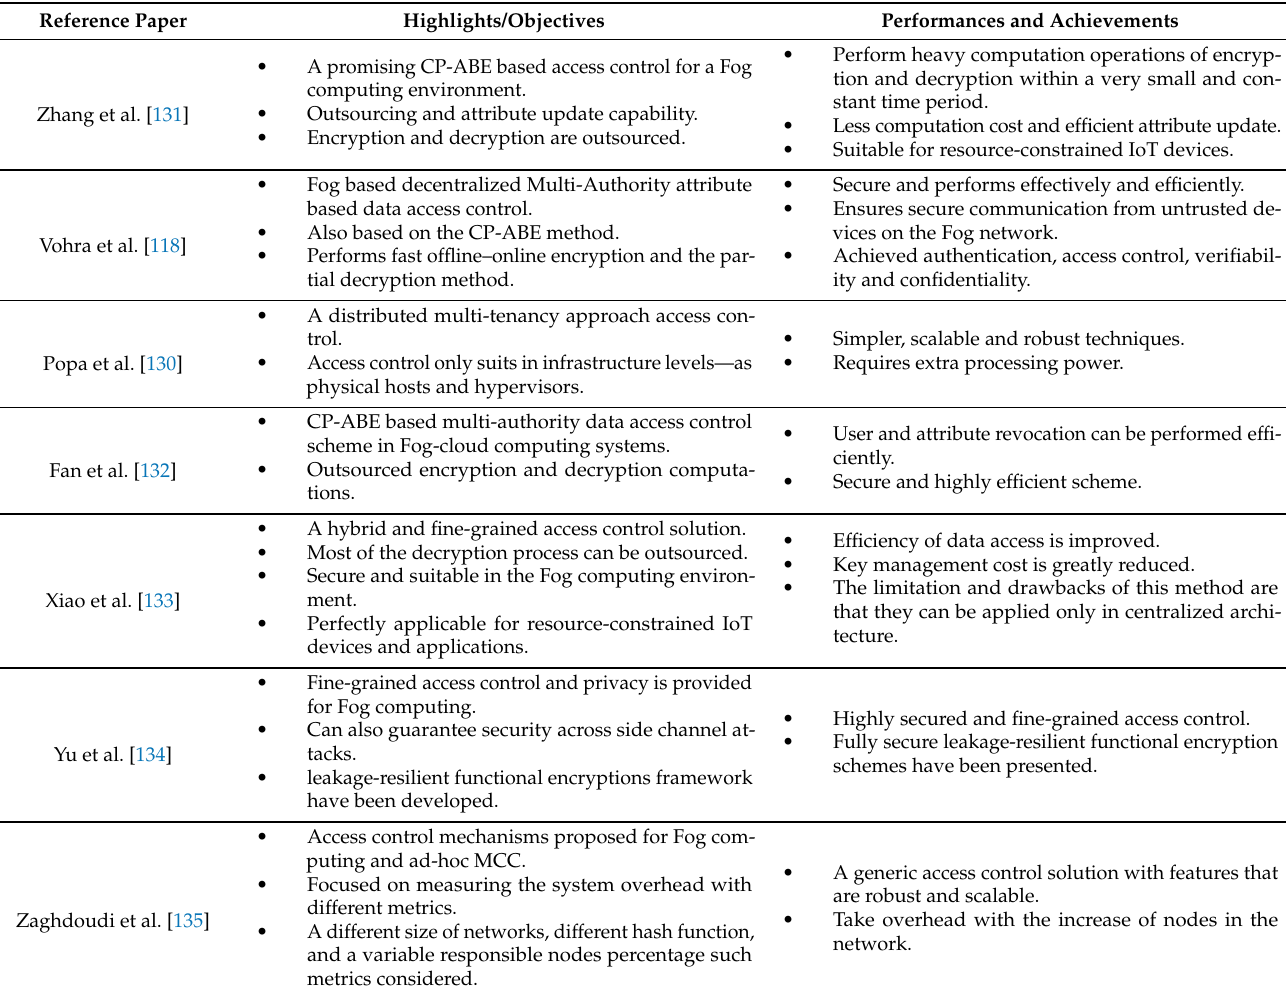
Table 9. The summary of Access Control Issues in the Fog environment across major survey